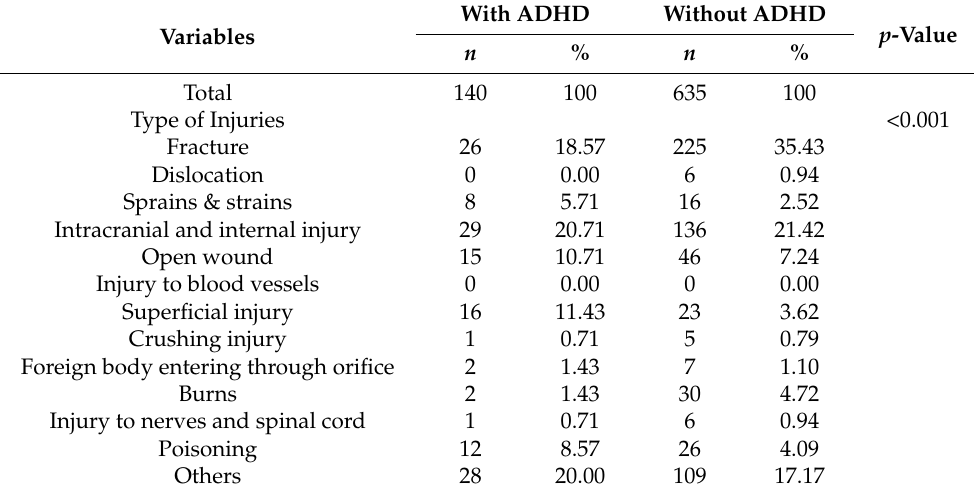
Table 5. Injured hospitalized child by injury type and group at the end of follow-up. With ADHD Variables